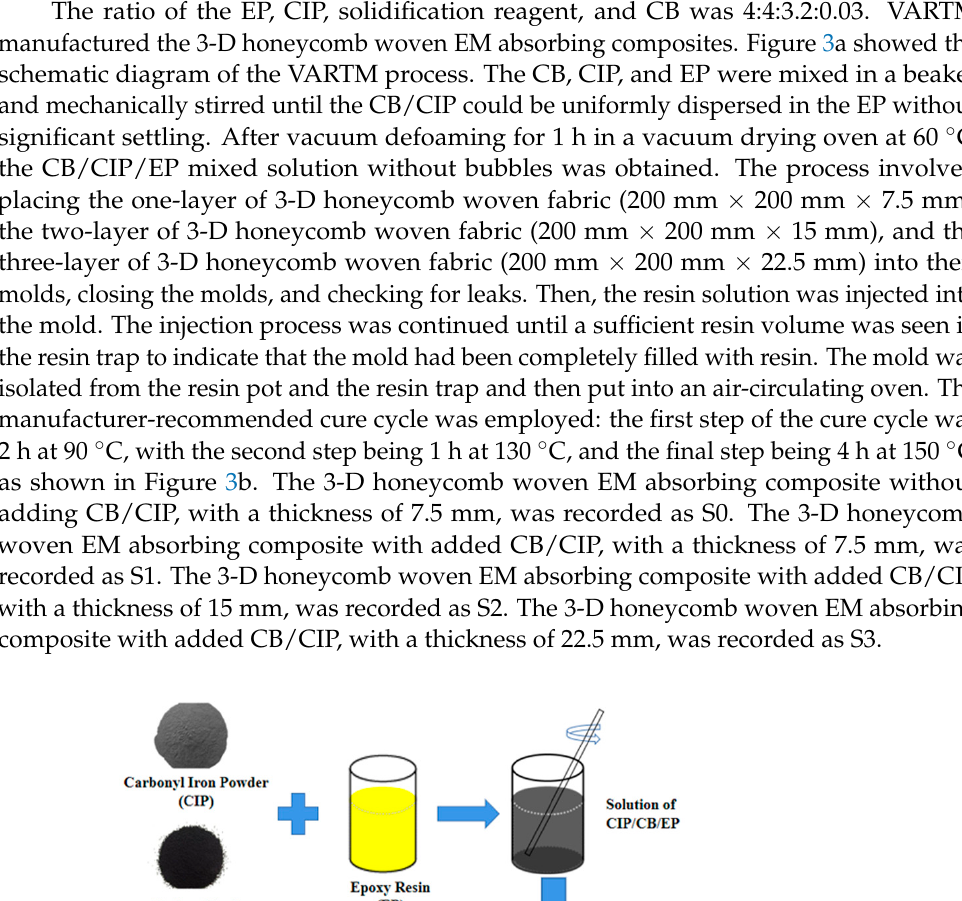
( b ) Figure 3. ( a ) Schematic diagram of VARTM process; ( b ) high-temperature curing process diagram of the 3-D honeycomb woven EM absorbing composite. 2.4. Characterization Methods The EM parameters of the CB/CIP were tested by the coaxial method. The specimens were prepared by homogeneously mixing the CB/CIP with the paraffin in a mass ratio of 0.03:4:4; the mixture was pressed into a toroidal shape with an inner diameter of 3.04 mm and an outer diameter of 7 mm. The schematic of the experimental setup is shown in Fig- ure 4a. The morphology of the absorbent was observed with the scanning electron micro- scope JSM-7800F (JEOL Ltd., Guangzhou City, China) in the high-vacuum. The applied accelerating voltage was 15 kV and the working distance was 10 mm.